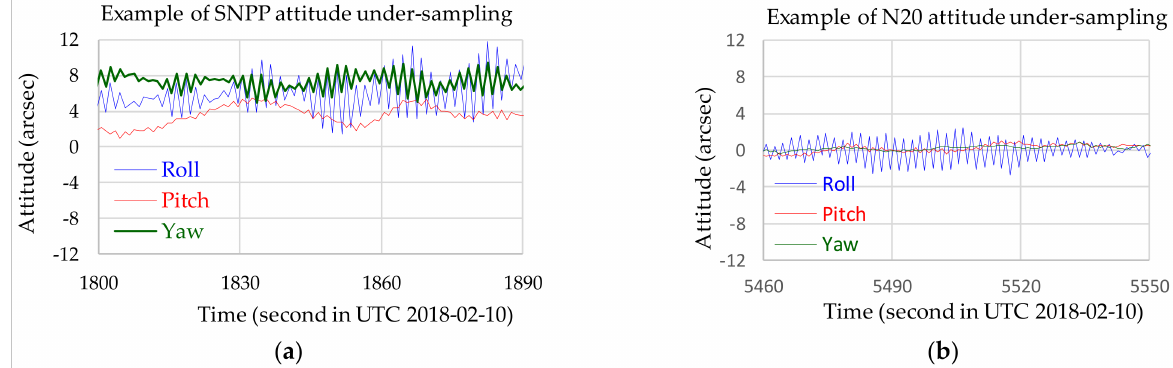
Figure 11. Examples of attitude under-sampling in 1 Hz from ( a ) SNPP and ( b ) NOAA-20 ADCS at 1 Hz that result in “beat frequencies” and aliasing in roll and yaw directions for SNPP and in roll direction in